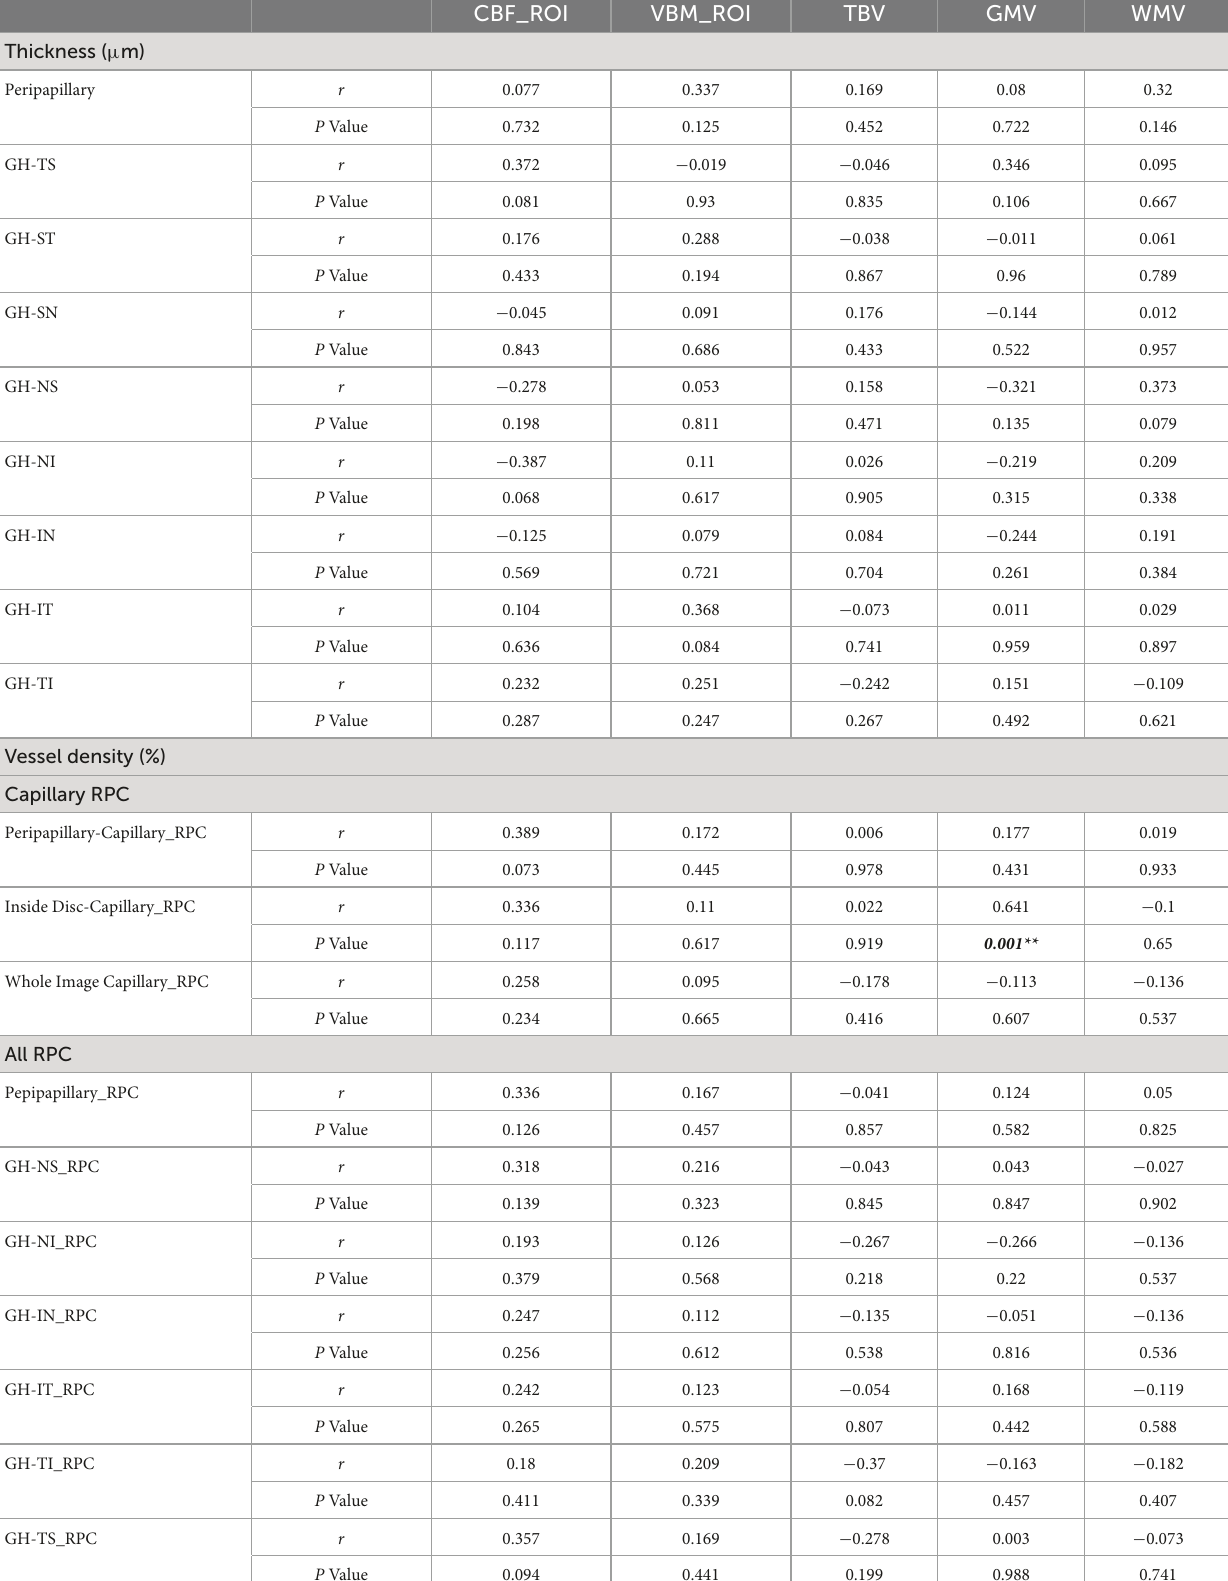
TABLE 4 Partial correlation analysis of neuroimaging and peripapillary parameters in mild AD group with adjustment for age, gender, education, and